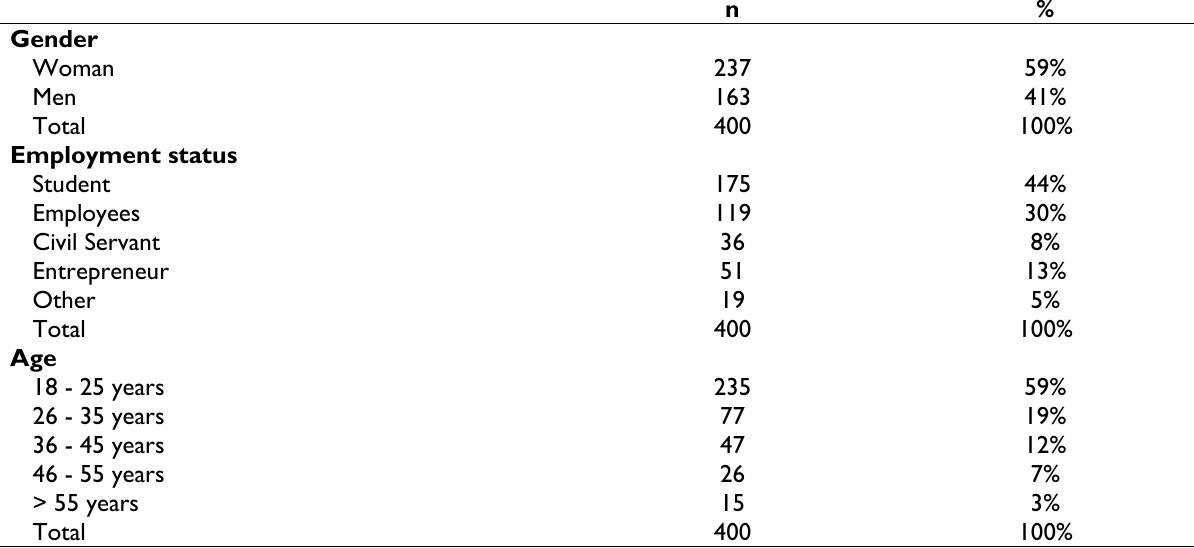
Table 2. Characteristics of